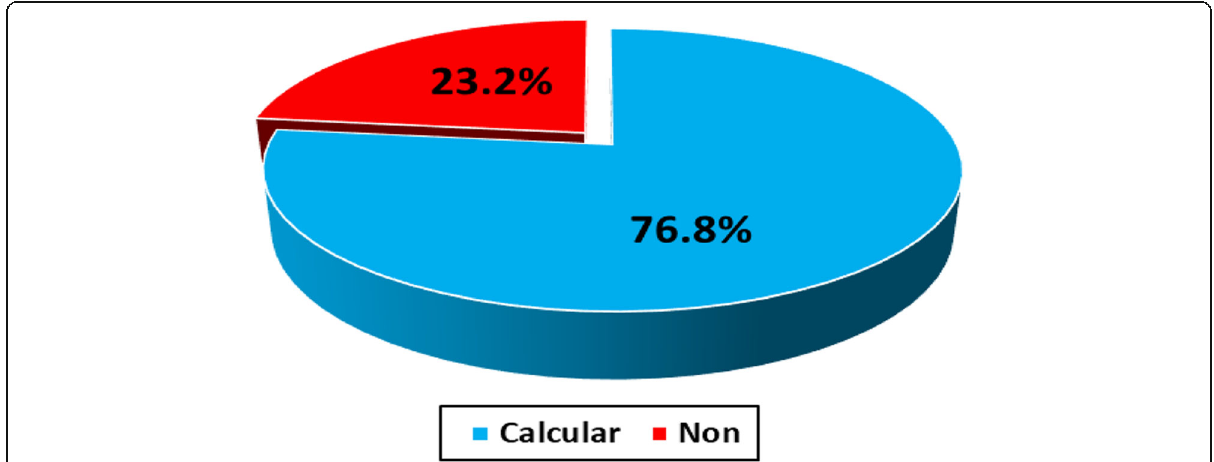
Fig. 3 Distribution of the sample according to the cause of disease